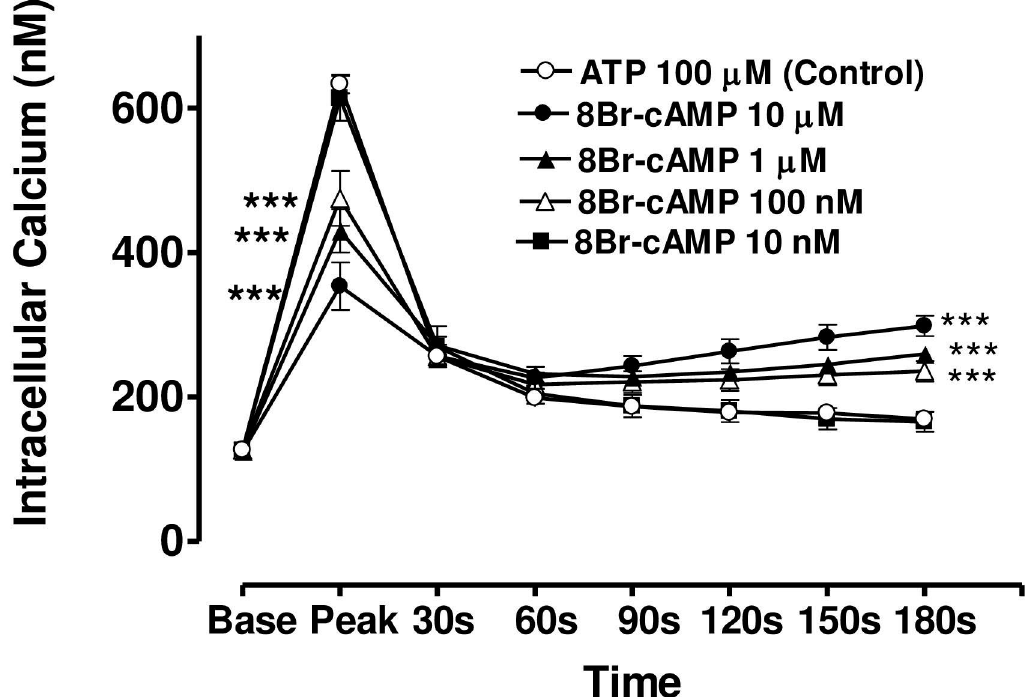
Fig 8. Effect of increasing concentration of 8-Br-cAMP on the Ca 2+ -mobilizing response of ATP (100 μ M) in bovine cultured CE, both at the peak of the Ca 2+ transient and at selected time intervals thereafter. Cultured cells were incubated for 6 min with appropriate concentration of 8-Br-cAMP in HEPES bufererd Krebs’ solution containing 1.8mM calcium. The cells were then exposed to 100 μ M of ATP. Each point represents a mean ± s.e.mean of 8–15 experiments. Significance of differences between incubations with or without 8-BR-cAMP; �� p < 0.01 and ��� p < 0.001, Bonferroni’s multiple comparison test. Base value indicates the [Ca 2+ ] i prior to addition of ATP.